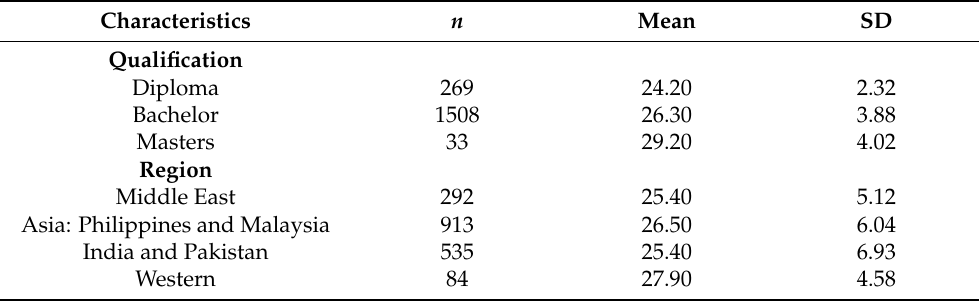
Table 4. Mean total facilitator score for nurses’ region where qualification or qualifications